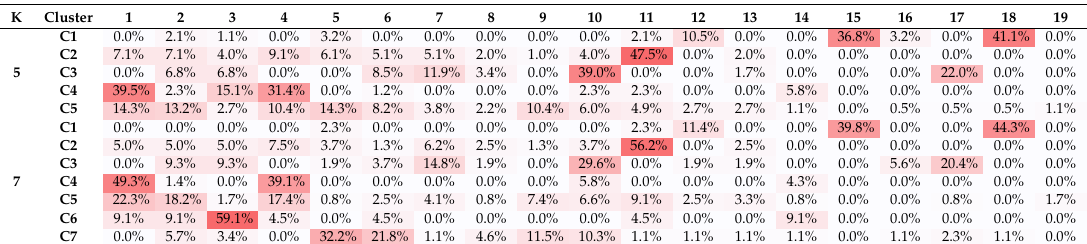
Table 4. Clustering results. A higher percentage value means that the cluster has a higher proportion in top-level types, that is, it is more similar to this type. The numbers denote the type IDs of the top-level types, for example, “1” represents the “Shopping